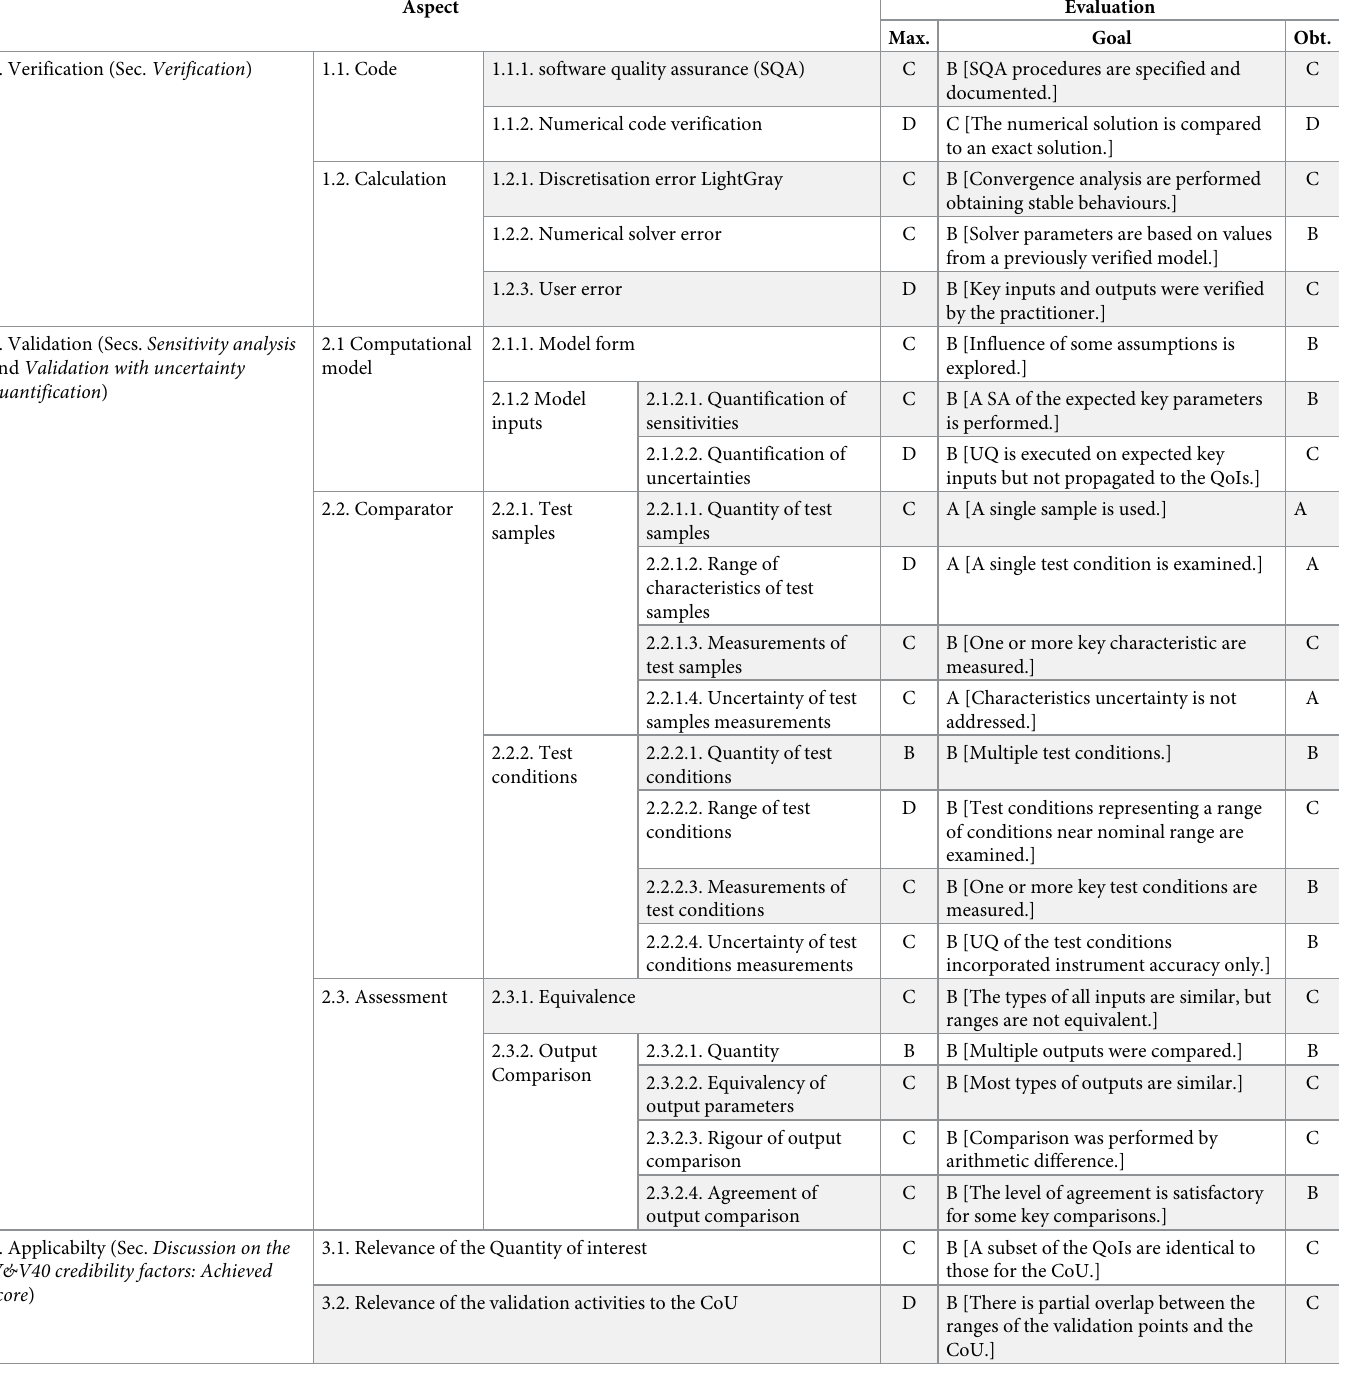
Table 3. ASME V&V40 credibility factors [11] analysed on the risk-based assessment. The table shows the maximum possible score (“Max.” column), the desired goal (“Goal” column) and the obtained score (“Obt.” column). The goal column also includes the description of the activity to achieve that